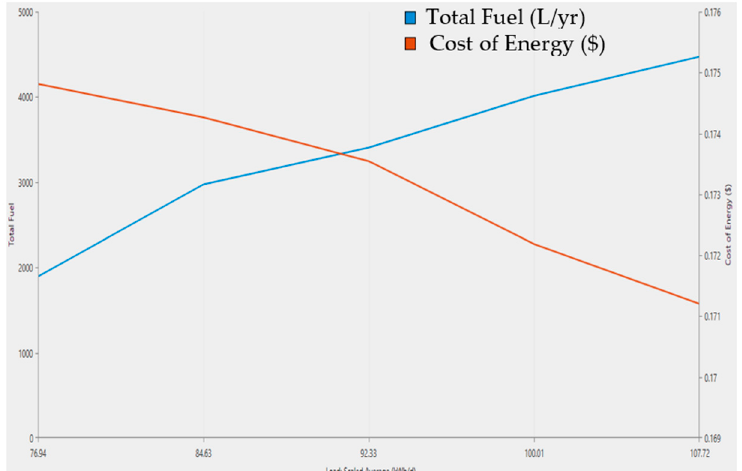
Figure 19. Total fuel usage and LCOE related to load variations.